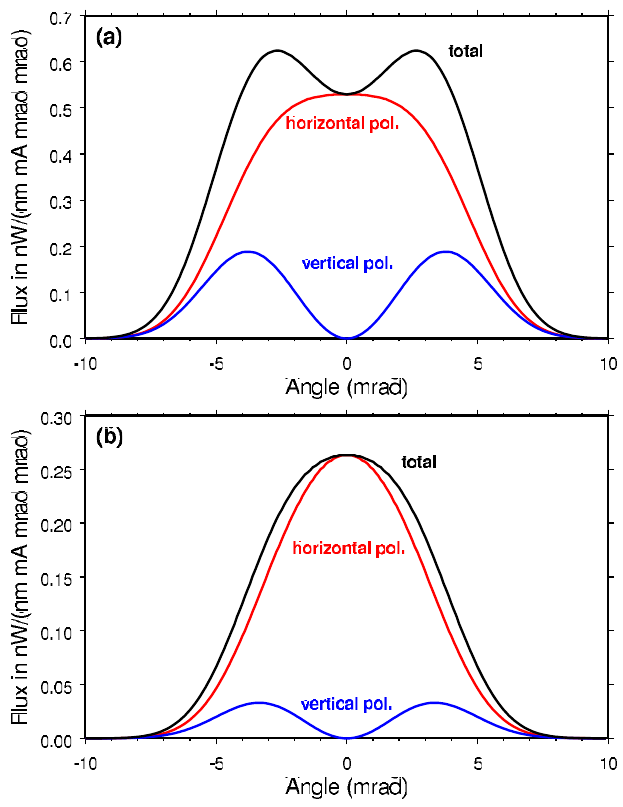
FIG. 1. (Color) Calculated angular distribution of synchrotron radiation in the vertical direction at 400 nm using SURF III parameters and 1 mA of current for (a) 380 MeV and (b) 105 MeV electron energy. The orbit is in the horizontal plane. The curves shown represent radiation from two different polarization states as well as their